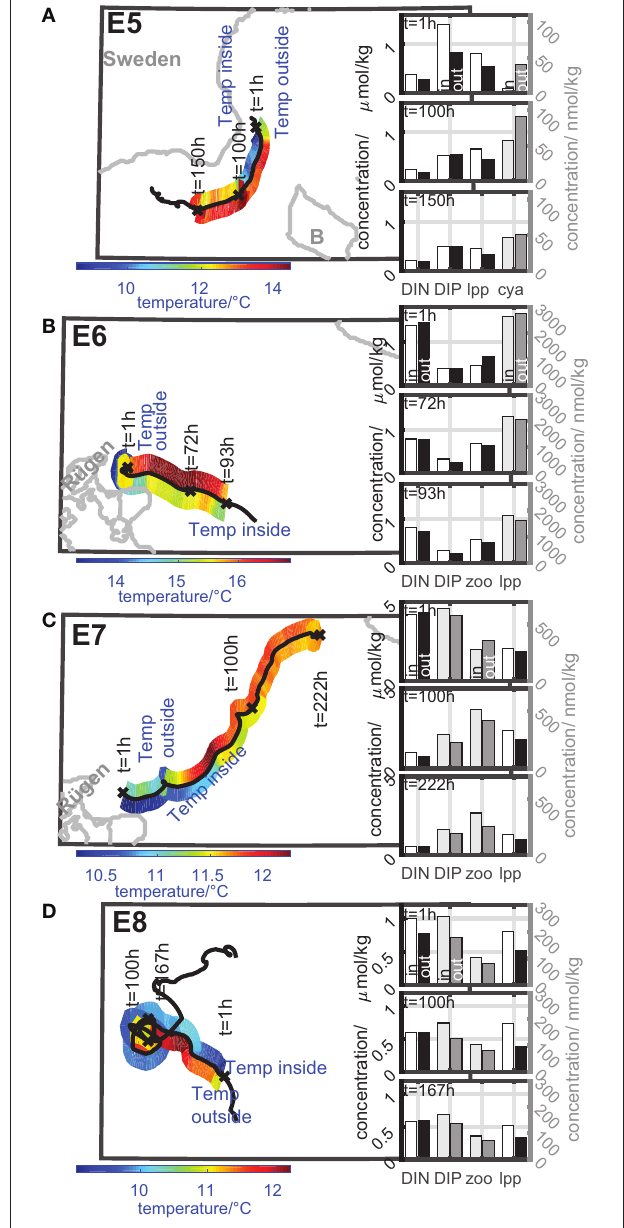
FIGURE 7 | Color-coded dynamics of the temperature inside and outside the eddy along the eddy track during its coherence time of eddies with niche properties ( (A) E5, (B) E6, (C) E7, and (D) E8). Insert bar plots: concentration of nutrients and selected plankton groups inside and outside the eddy at selected timesteps of the concentration time series. Left concentration axis: black and white bars; right concentration axis: gray scaled bars. Dynamics inside the eddy: white and light gray bars; dynamics outside the eddy: black and dark gray bars. Further details see text.